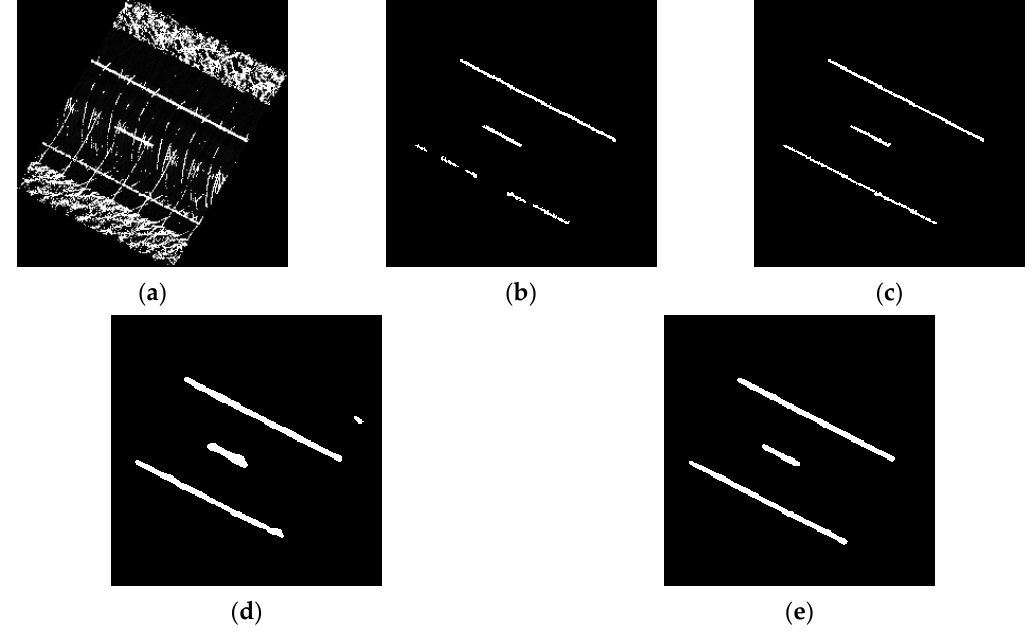
Figure 26. Concrete pavement area (for location ii in Figure 24): ( a ) original intensity image and predicted lane marking images from ( b ) original intensity thresholding, ( c ) normalized intensity thresholding, ( d ) U-net model 1, and ( e ) U-net model 2.